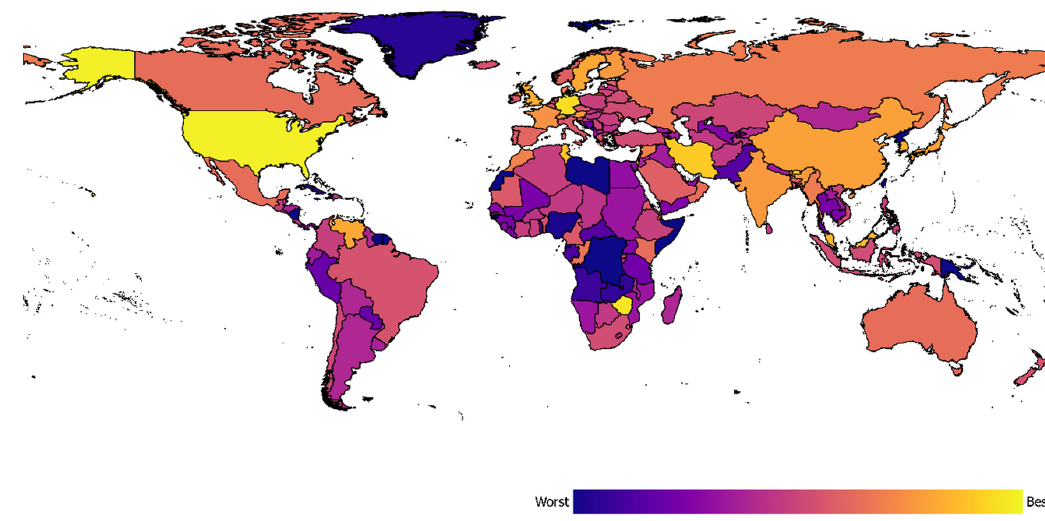
Figure 13. Global view on the literacy